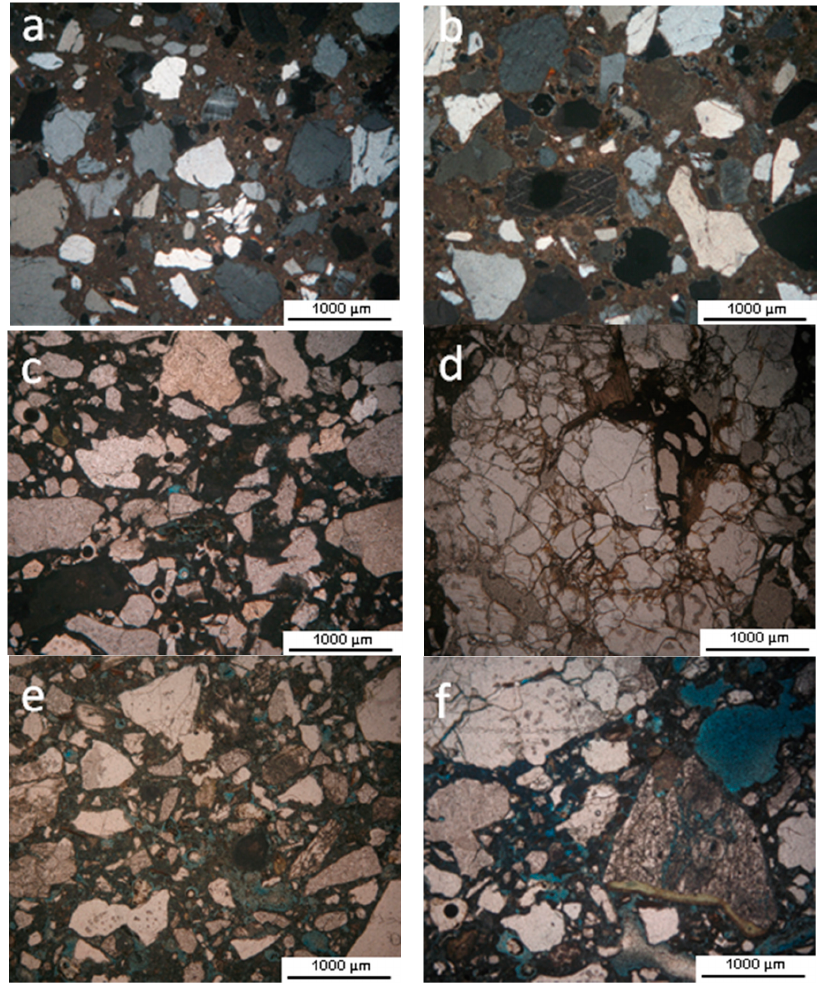
Figure 6. Petrographic observation of samples. ( a ) general aspect of the mortar showing the presence of polycrystalline quartz grains, feldspars and small fragments of carbonates (sample S-005, 2.5 × , #); ( b ) carbonate fragment (sample S-002, 5.0 × , #); ( c ) irregular porosity (sample S-002, 2.5 × , //); ( d ) ochre staining (sample S-002, 2.5 × , //); ( e ) sample with high porosity (sample S-007, 2.5 × , //); ( f ) altered K-feldspar (sample S-007, 5.0 × , //). #: parallel and //: perpendicular. Minerals 2018 , 8 , x FOR PEER REVIEW